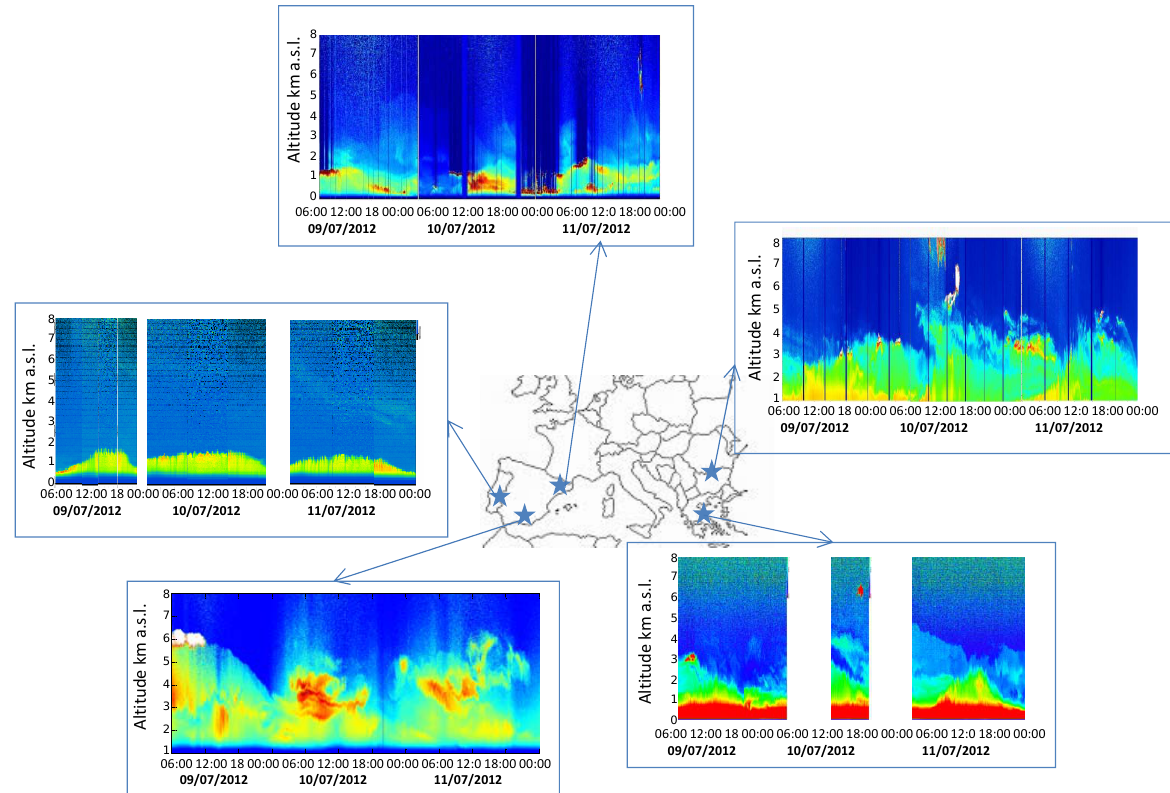
Figure 3. RCS at 532nm (1064nm at Athens) in arbitrary units for the five stations during the ChArMEx 2012 measurement campaign.